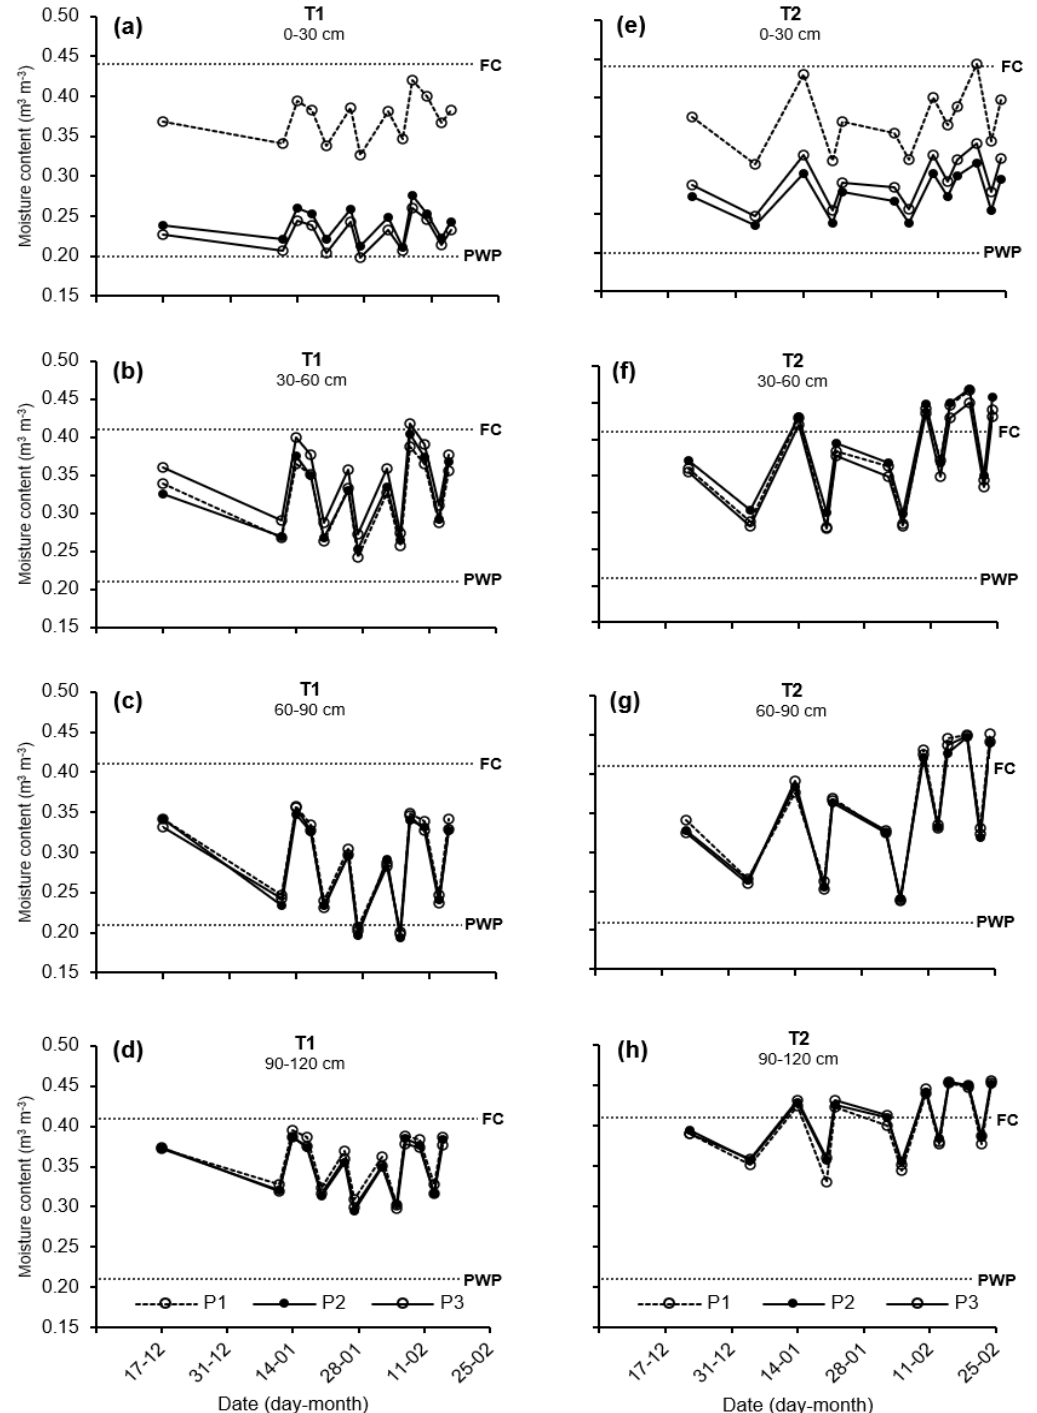
Figure 8. Evolution of soil moisture content before irrigation in the ( a , e ) 0–30 cm, ( b , f ) 30–60 cm, ( c , g ) 60–90 cm, and ( d , h ) 90–120 cm strata throughout the 2009–2010 irrigation season for two drip irrigation treatments of ‘Brookfield Gala’ apple trees. T1: Irrigation with theoretical volume required by the plant. T2: Irrigation with farm protocol. Each point is the average of 12 readings. FC is field capacity and PWP is permanent wilting. The moisture content measurement points are P1: 60 cm from the trunk between rows, P2: 30 cm from the trunk within the row, and P3: 60 cm from the trunk within the row.